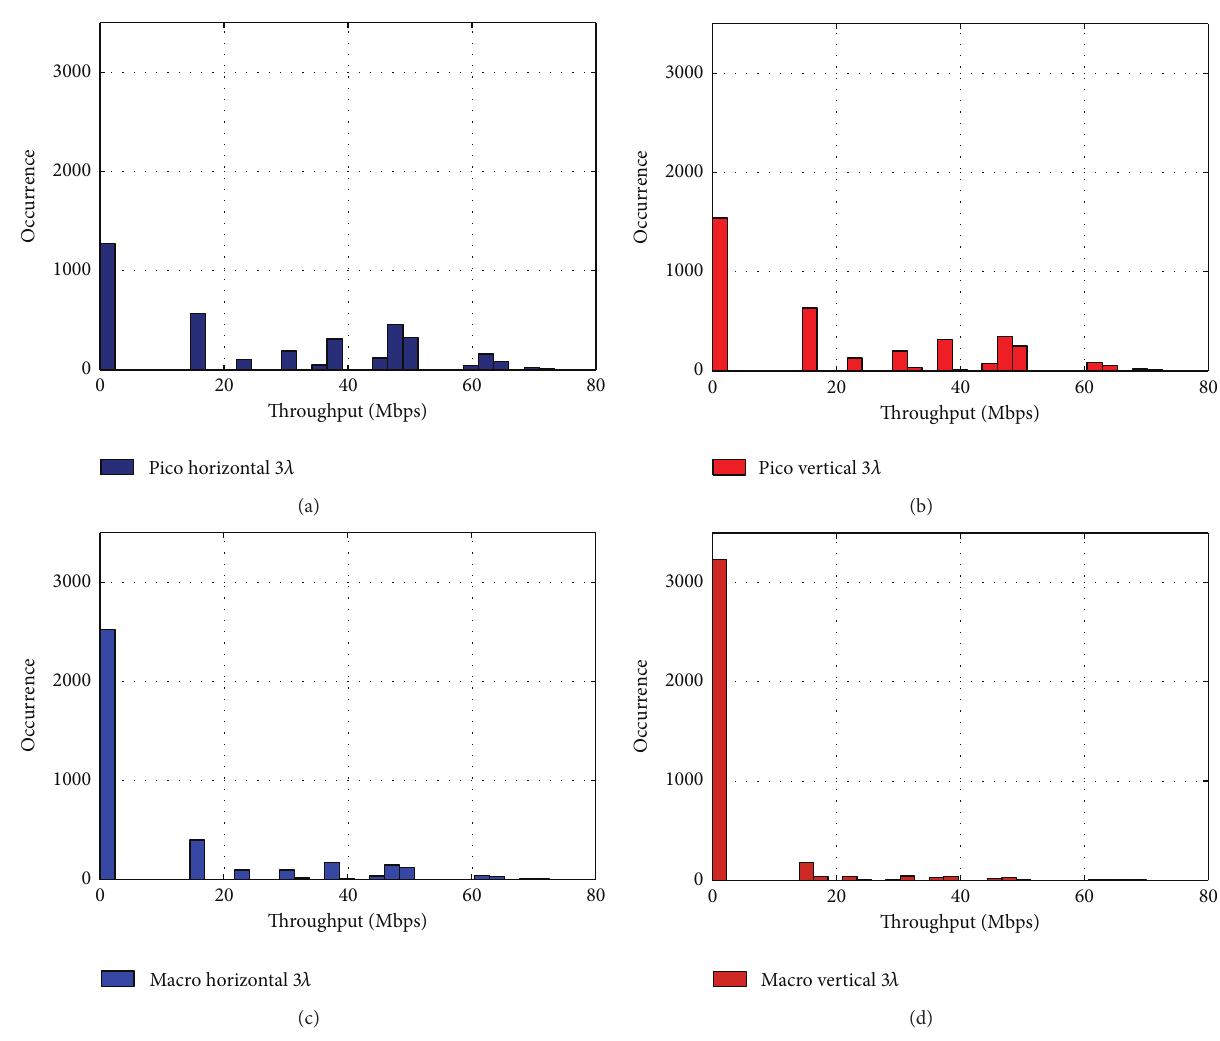
Figure 9: Throughput occurrence statistics for vertical and horizontal eNB antenna array configurations (NLoS links only) with BS antenna separation of 3𝜆 (total number of occurrences is 3,729 for picocells and 3,681 for